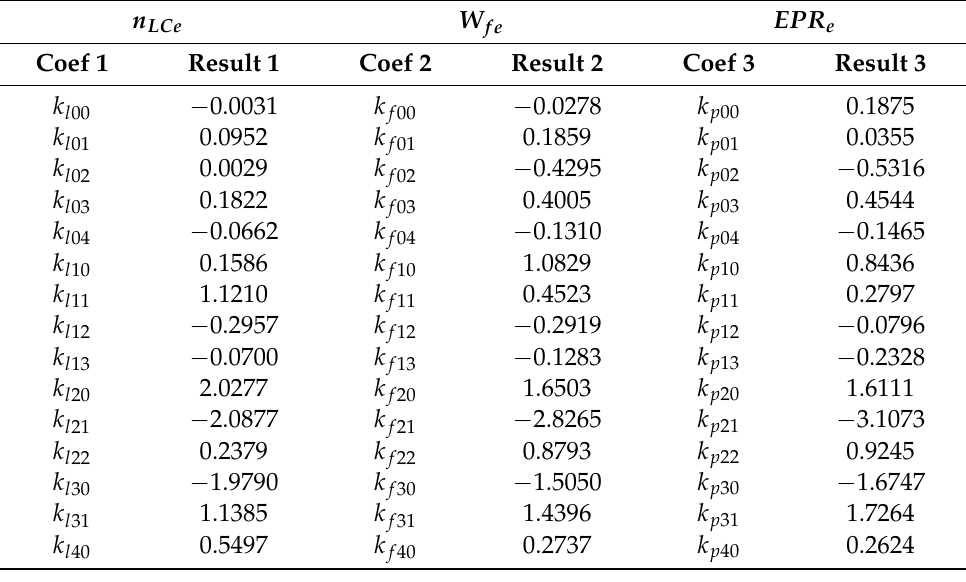
Table 2. The coefficients of the EM ( α = [ n HC , A n ]) .